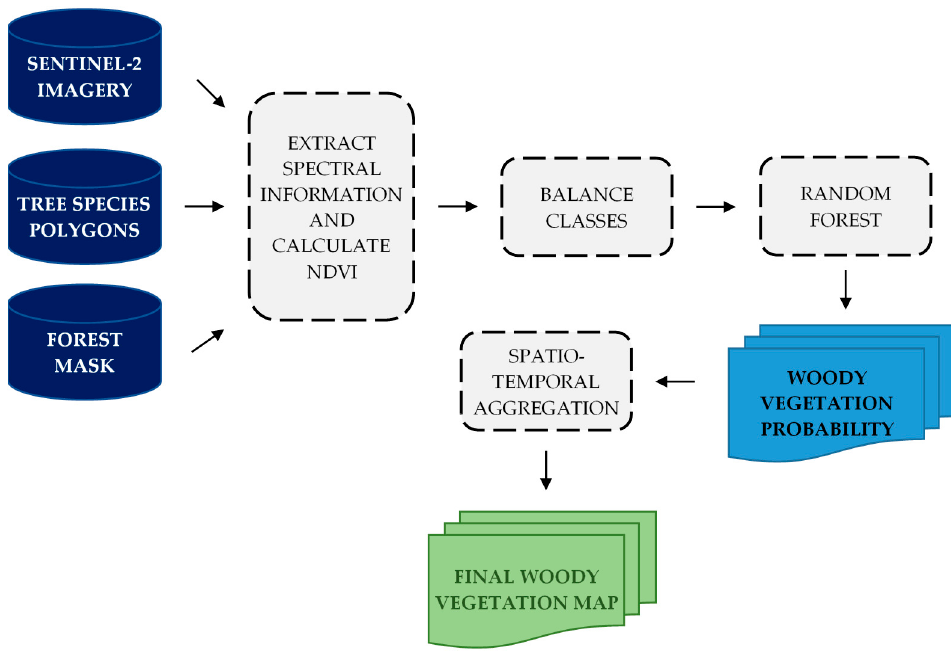
Figure 4. The flowchart diagram of the proposed spatio-temporal classification framework.